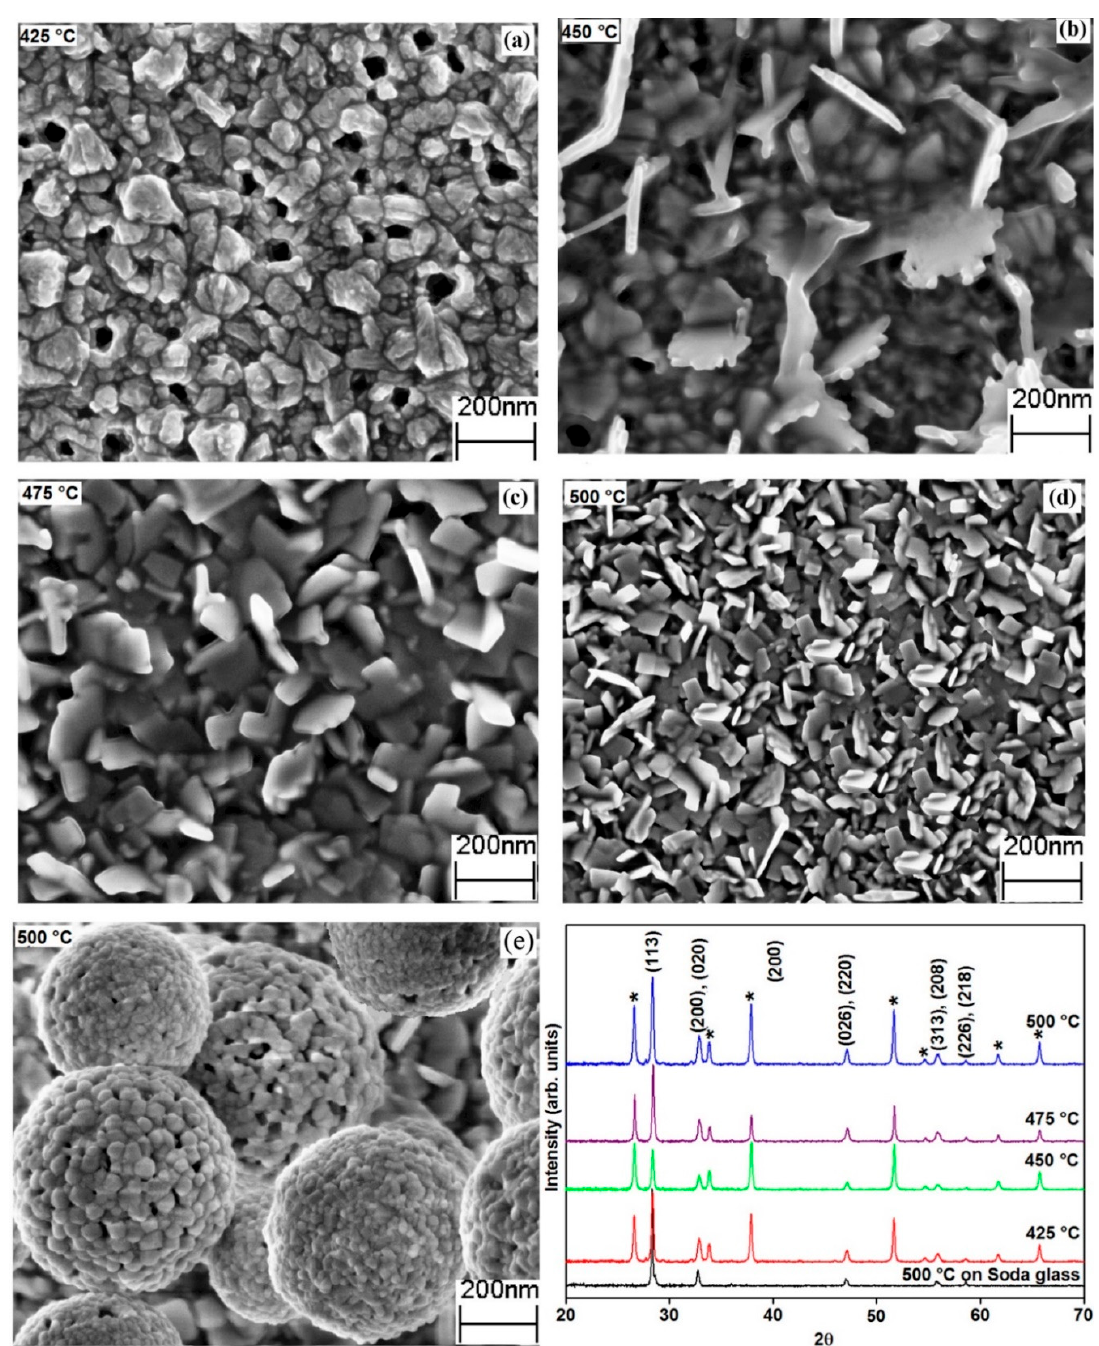
Figure 1. The scanning electron microscope (SEM) images ( a – d ) deposited at 300mL/mint flow rate ( e ) at 500 °C with 100 mL/min carrier gas flow. The X-ray diffraction (XRD) spectra of electrodes at deposition temperature of 425–500 °C, the peaks marked with (*) belong SnO 2 arises from the Fluorine doped tin oxide (FTO) substrate.